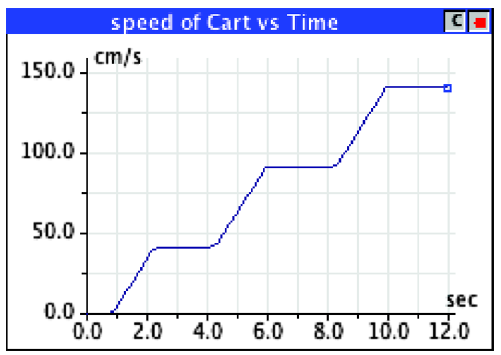
FIG. 1 (color online). Simulator generated speed-time graph.